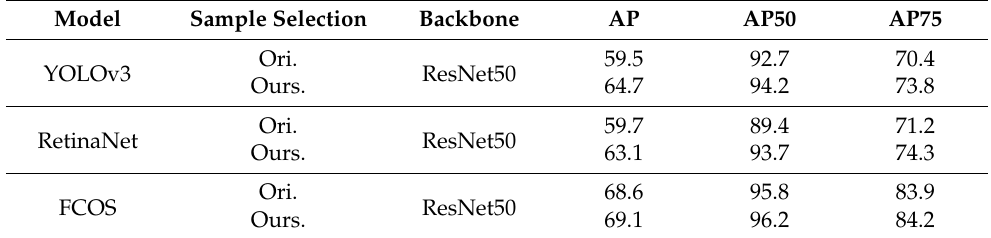
Table 2. Detection results of different models with different sample definition methods on BCTSDB.